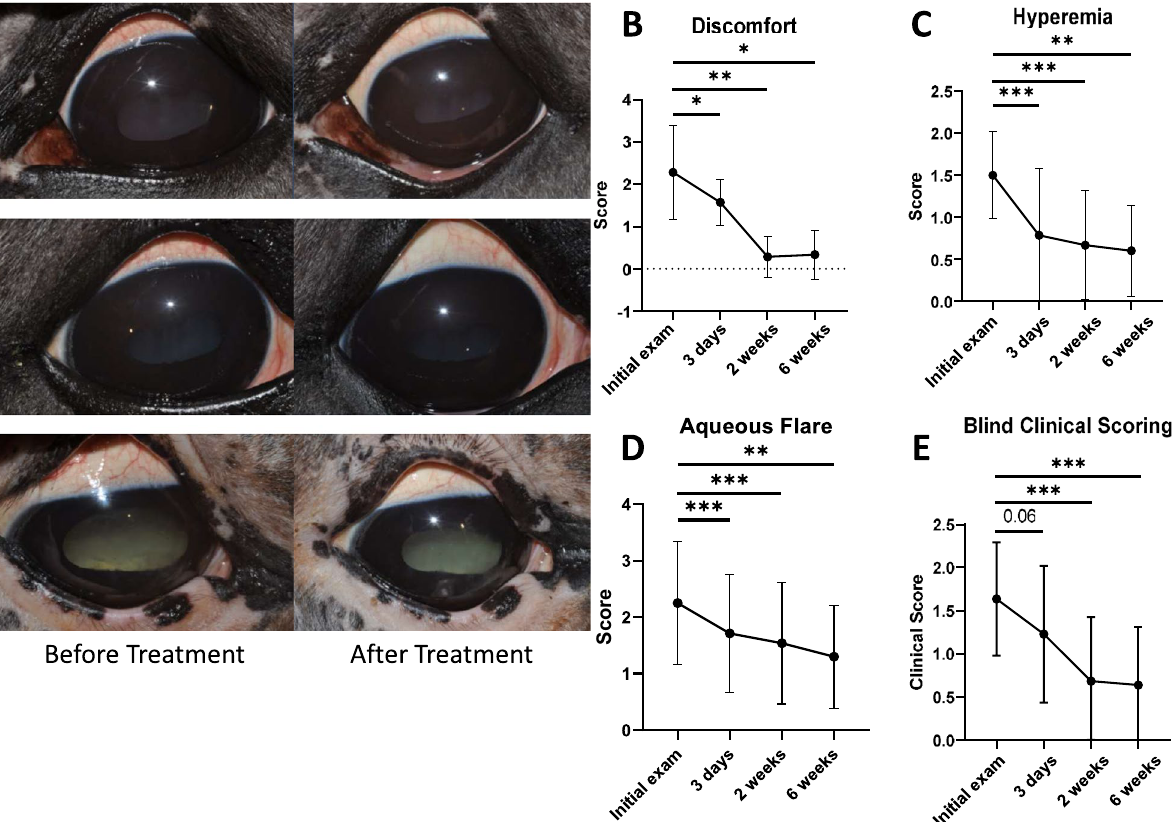
Figure 4. SOCS1 KIR Mitigates Equine Recurrent Uveitis Associated Pathology In Vivo . ( A ) Images of 3 representative horse eyes before and after treatment of SOCS1 KIR for 6 weeks ( B ) Average score of discomfort over the course of 6 weeks topical SOCS1 KIR treatment (n = 8). Horse eyes that did not exhibit any signs of discomfort were omitted from the analysis. ( C ) Average score of hyperemia over the course of 6 weeks topical SOCS1 KIR treatment (n = 14). ( D ) Average score of aqueous flare over the course of 6 weeks topical SOCS1 KIR treatment (n = 14). E) Images of 11 horse eyes at 4 different time points were provided to blinded veterinarians and clinically scored based on the criteria from the modified McDonald-Shadduck scoring system. (n = 8). P -values (* = ≤ 0.05, * * = ≤ 0.01, * * * = ≤ 0.001) were obtained by a paired two-tailed student’s